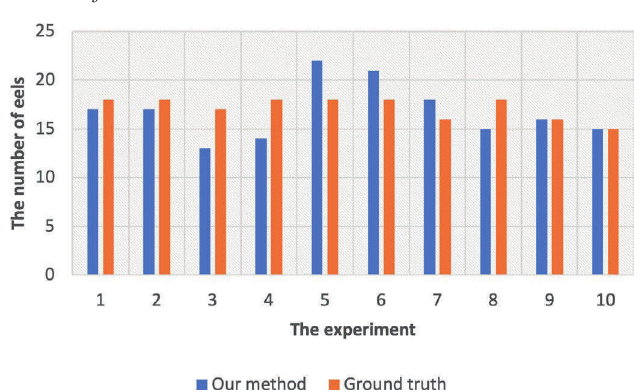
Fig. 12. Comparison of results between our method and ground truth.